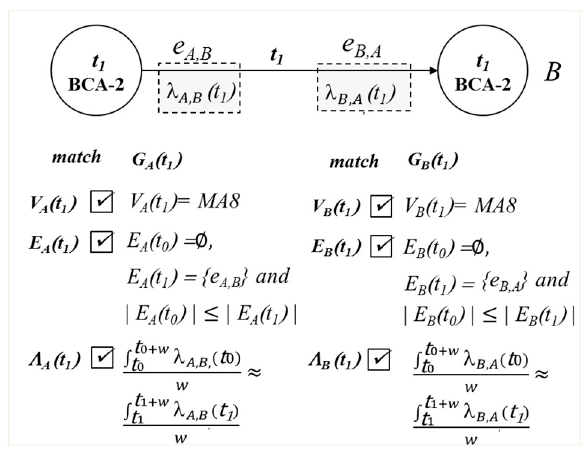
Figure 5. Combination of BCA-2.